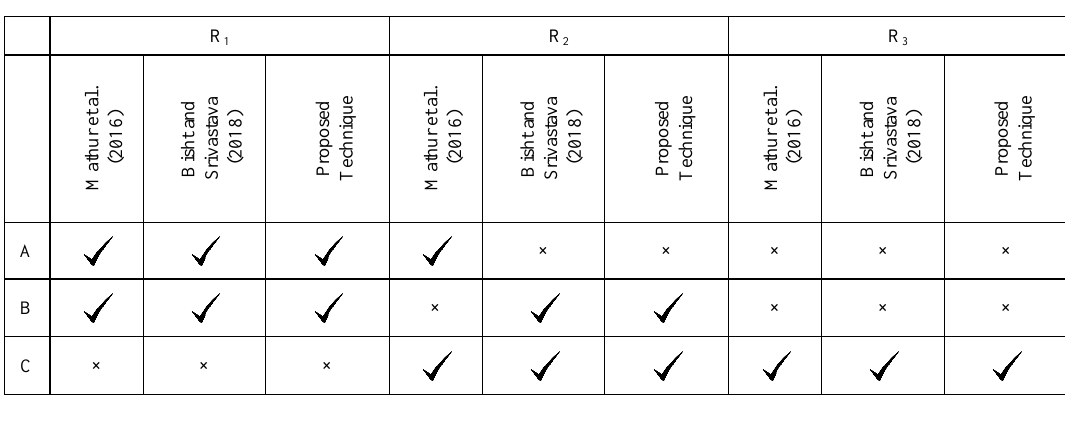
Table 14. Comparative study of Example 1